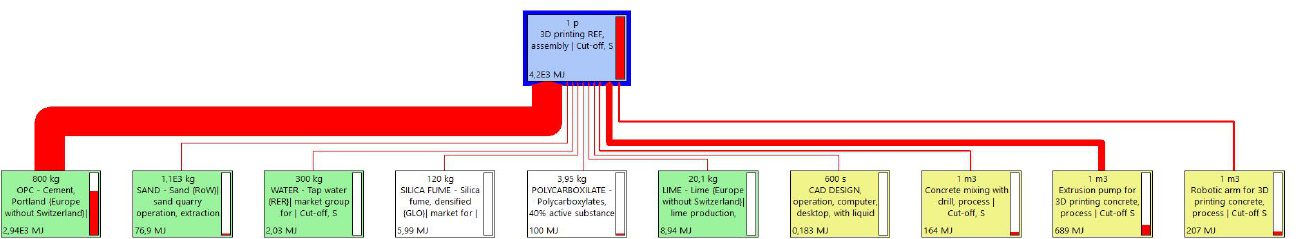
Figure A5. SimaPro CED network for p-CTR mix processing.